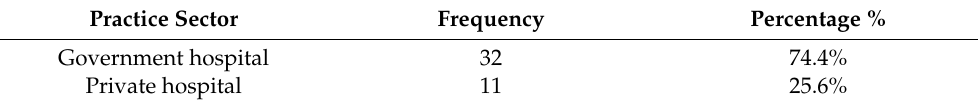
Table 3. Practice sector.